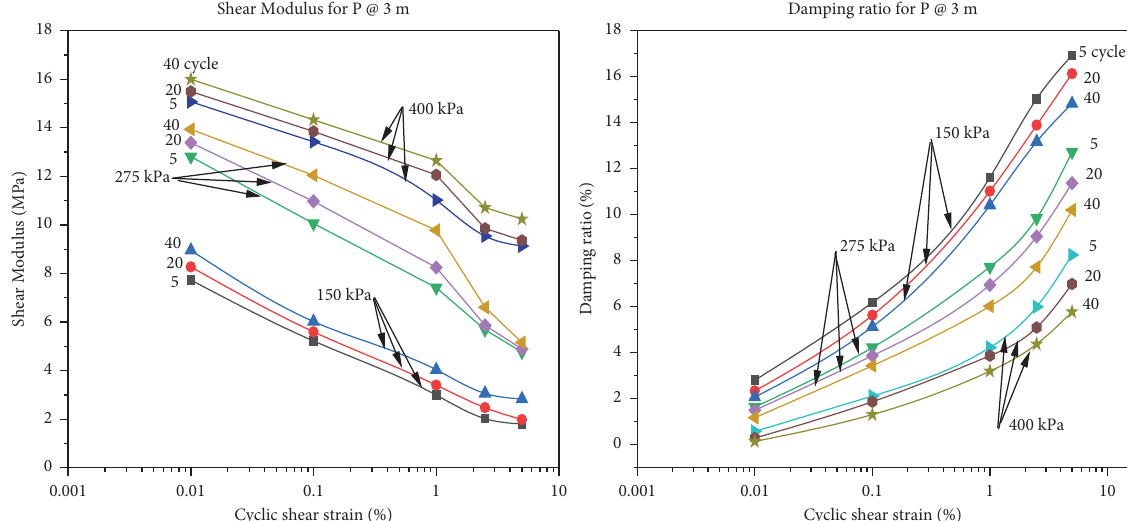
Figure 9: Infuence of confning pressure and shear strain amplitude on shear modulus and damping ratio values of P @ 3m.